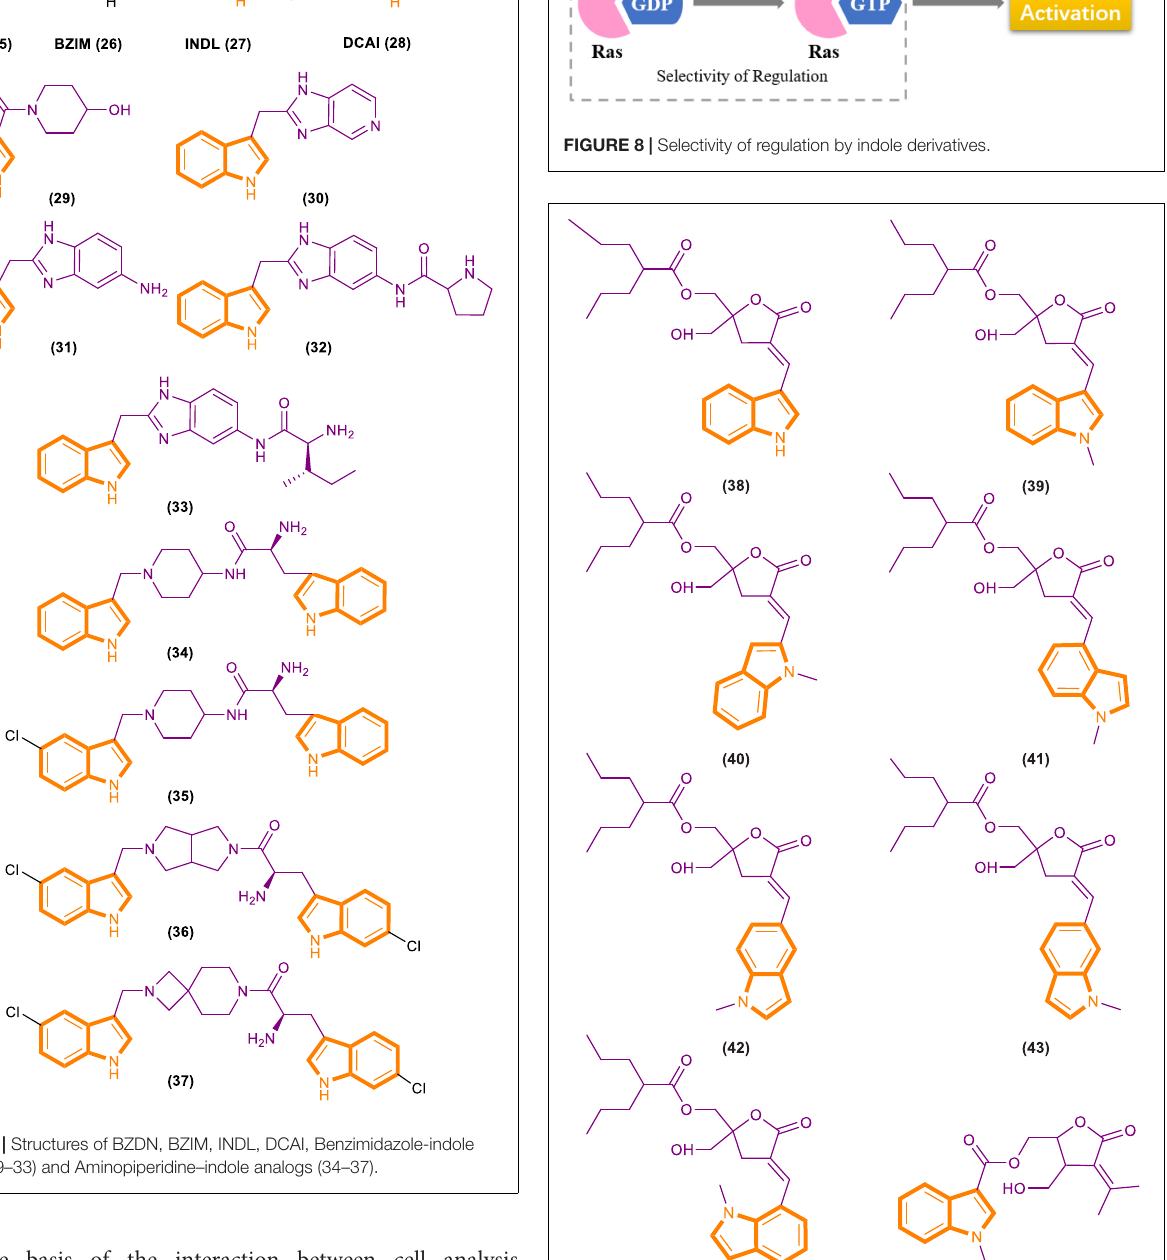
On the basis of the interaction between cell analysis and biophysical analysis with a model membrane, Jelinek and Comin’s groups synthesized DAG-indololactone analogs, wherein indole rings are linked to DAG in different positions (Garcia et al., 2014; Elhalem et al., 2017). Compound 39 ( Figure 9 ), which has an indole substituted at the R3 position, presents excellent binding affinity and selectivity to RasGRP1 as evidenced by its ClogP value of 5.0 and selectivity for PKC α , PKC ε , and RasGRP1 [the binding affinities of compounds